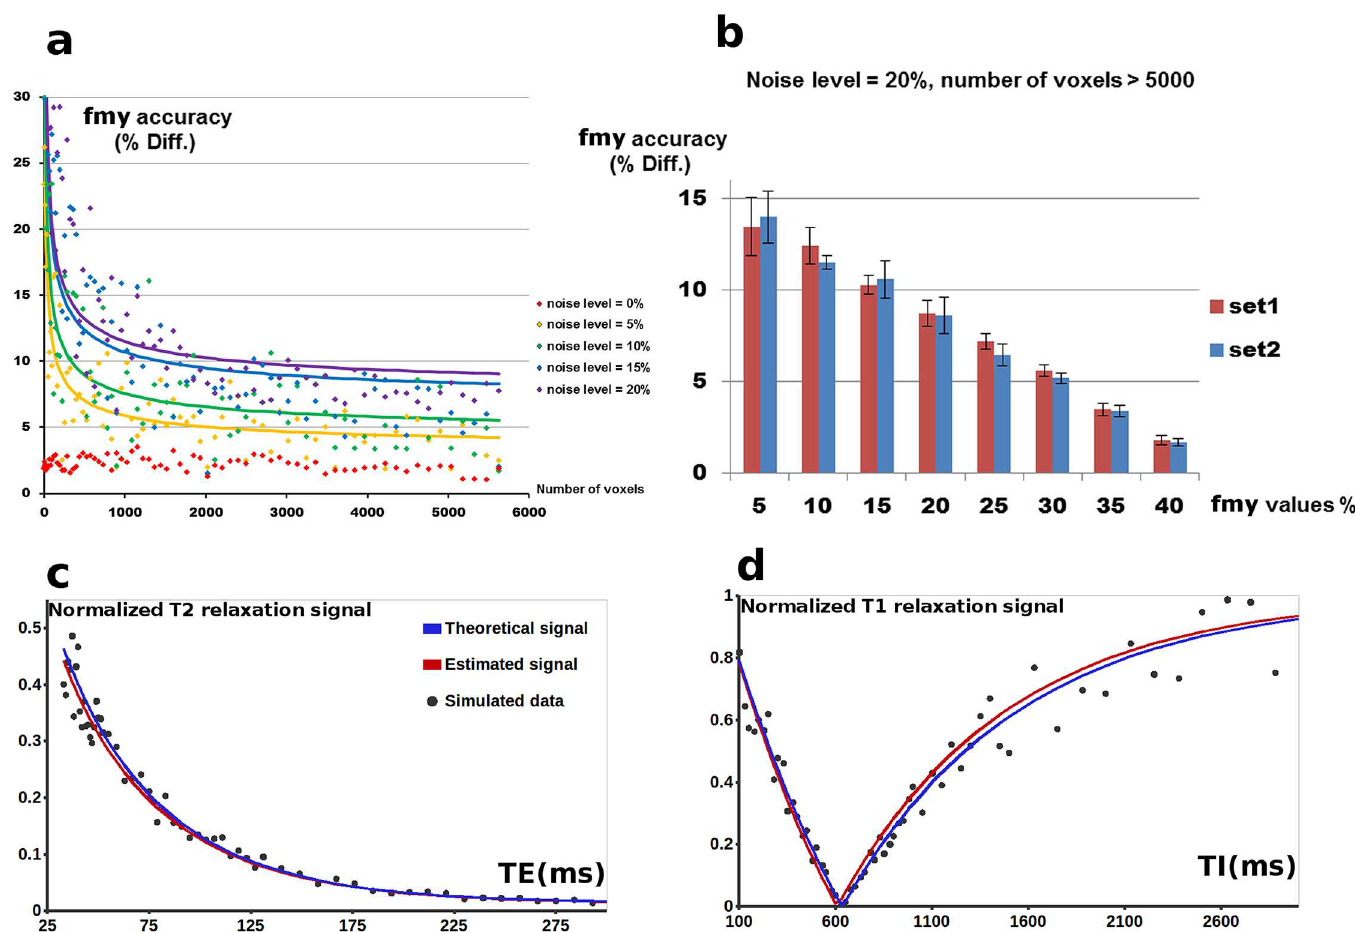
Fig 4. f my calculation accuracyat the calibration stage assessedin numerical simulations. (a) The f my calculation errors were calculated for simulated f my = [5,10,15,20,25,30,40]% and f csf = [0,1,2,3,4,5]%, and the resulting average values were represented as a function of the number of voxels used for the model fitting [1 2 , 2 2 , ... , 75 2 = 5625], for different noise levels (from 0 to 20%). As expected, relationship between the f my calculation errors and the number of voxels could be describedby inverse square root relationship( R 2 > 0.75). (b) For a noise level of 20%, calculationerrors for different simulated f my values were averaged for voxel numbers higher than 5000 ([71 2 , ... , 75 2 ]) and f csf = [0,1,2,3,4,5]%, considering T 1 c and T 2 c values fixed accordingto our calibration stage (set1) or to previous studies (set2 [9,19,34,35]). (c, d) Examples of the theoretical and estimated T2 (c) and T1 (d) relaxationsignals for data simulated with f my = 20%, f ie = 78%, f csf = 2% and T 1 c and T 2 c fixed accordingto our calibration